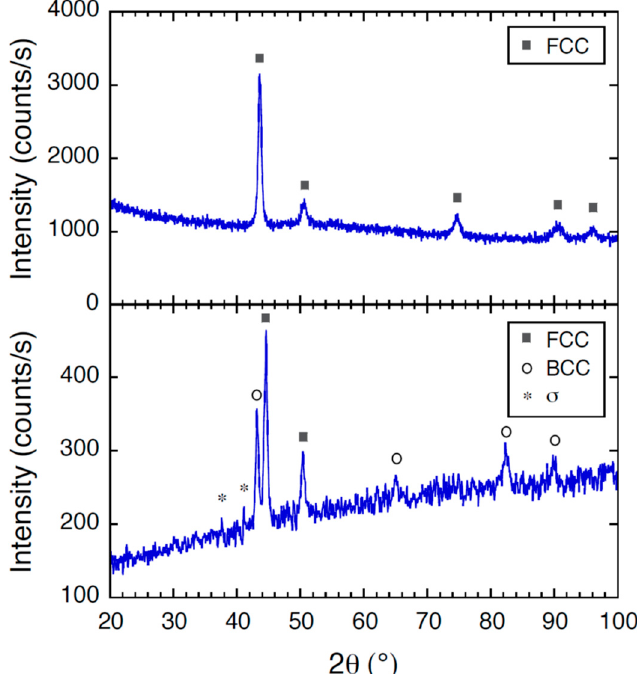
Figure 9. XRD pattern for CoCrFeNiMo ESD coating (bottom graph) and as-cast material (top graph) for comparison.